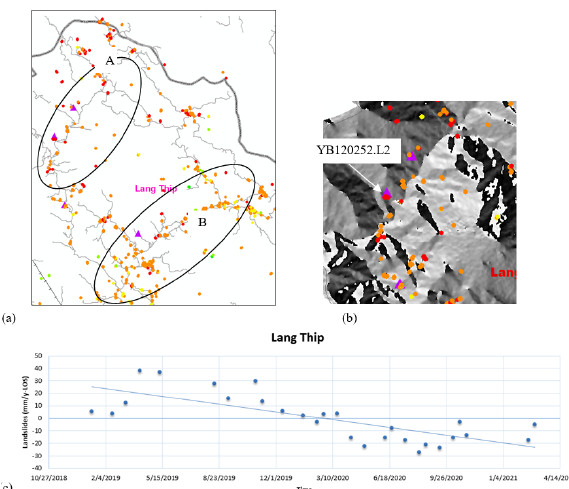
Figure 6. (a) Distribution of permanent scatter points showing landslide rate, (b) the positions of PS points matched with survey point in Lang Thip commune are superimposed on aspect map, (c) the chart of landslide point selected from (b).